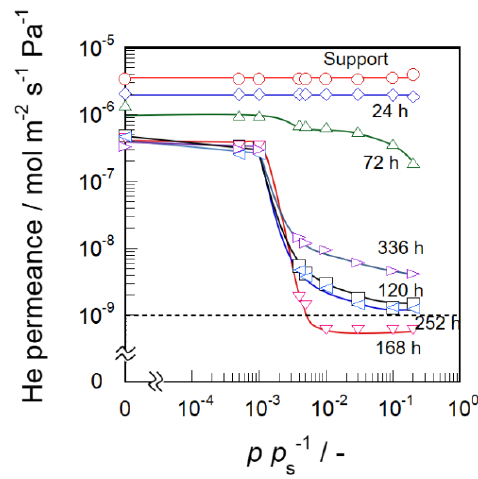
Figure 8. Results of nano-permporometry tests for silicalite-1 membranes with di ff erent crystallization period. O, Support; membrane crystallized for , 24; (cid:52) , 72; (cid:3) , 120; (cid:53) , 168; (cid:47) , 252; (cid:46) , 336 h.